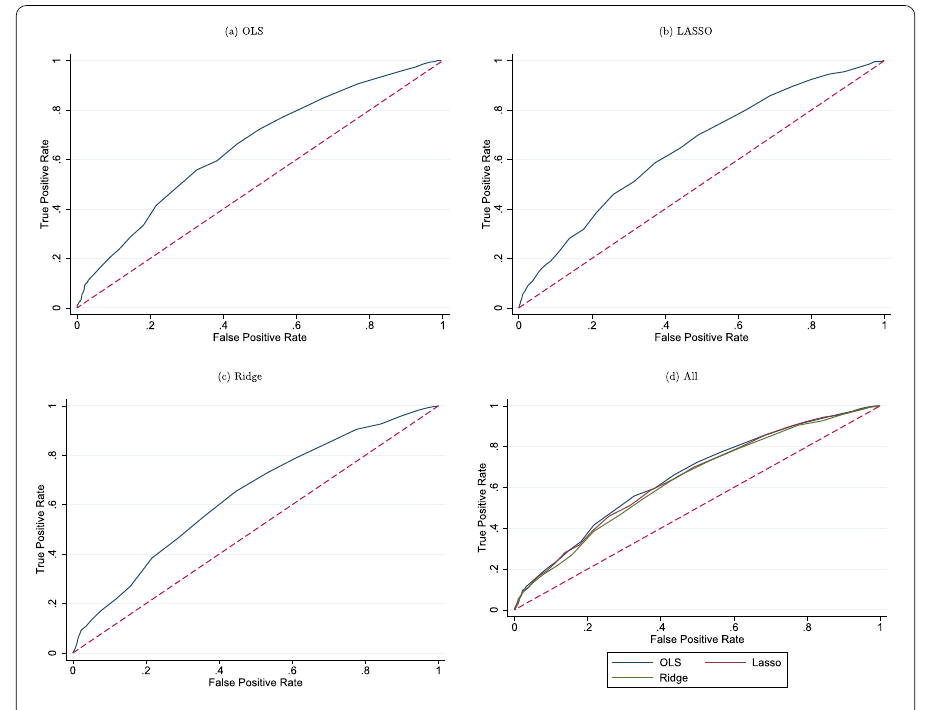
Figure A.5 ROC curves. Small model—verification data